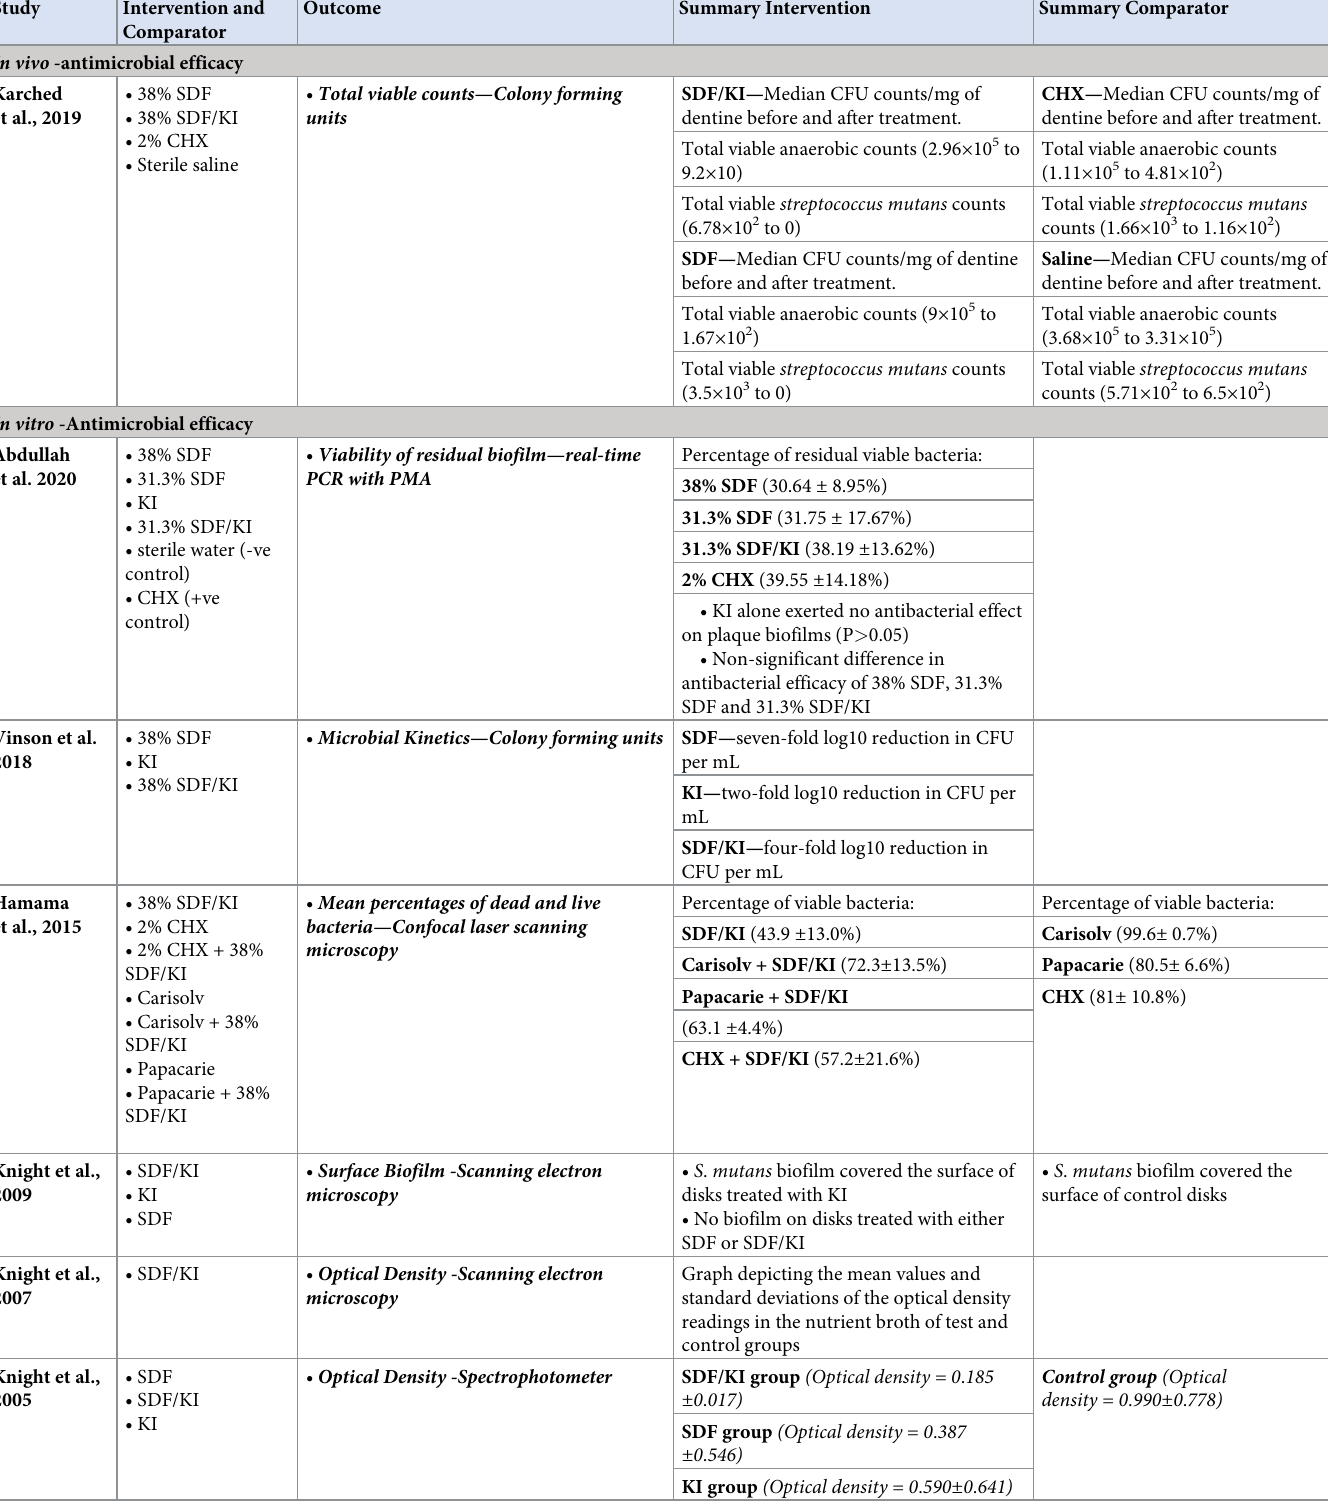
Table 4. Antimicrobial effect of